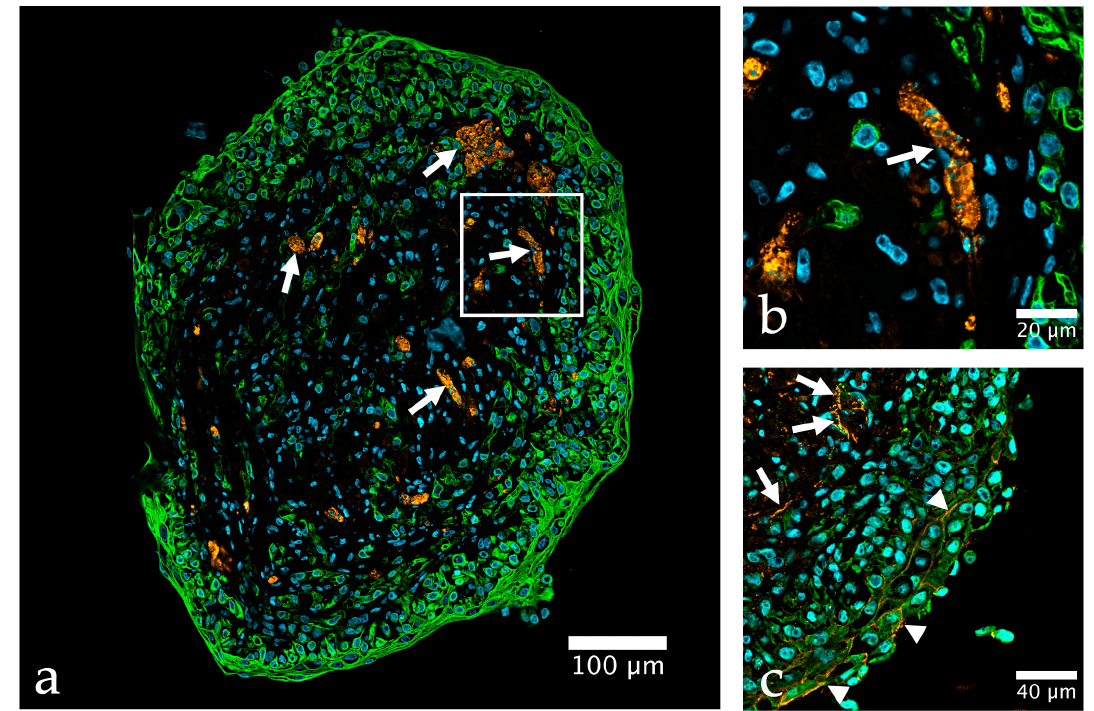
Figure 3. Organoid composed of HBF, HBSMC, HUVEC, and HBLAK, cultured for 14 days with 10 days of differentiation. ( a ) Immunohistochemical staining of cytokeratin 5 and 6 (CK5 + 6, green), von Willebrand factor (VWF, orange), nuclei are stained with TO-PRO-3 (blue), note the tubular structures formed by HUVEC (arrows); ( b ) detail of ( a ) showing the decoration of HUVEC with VWF; ( c ) zonula occludens protein-1 (ZO-1, orange) indicating barrier formation (arrowheads) by HBLAK stained with an antibody against CKPAN (green), note the labeling of tubular structures within the core of the organoid, probably HUVEC (arrows); antibodies used (Table S1).